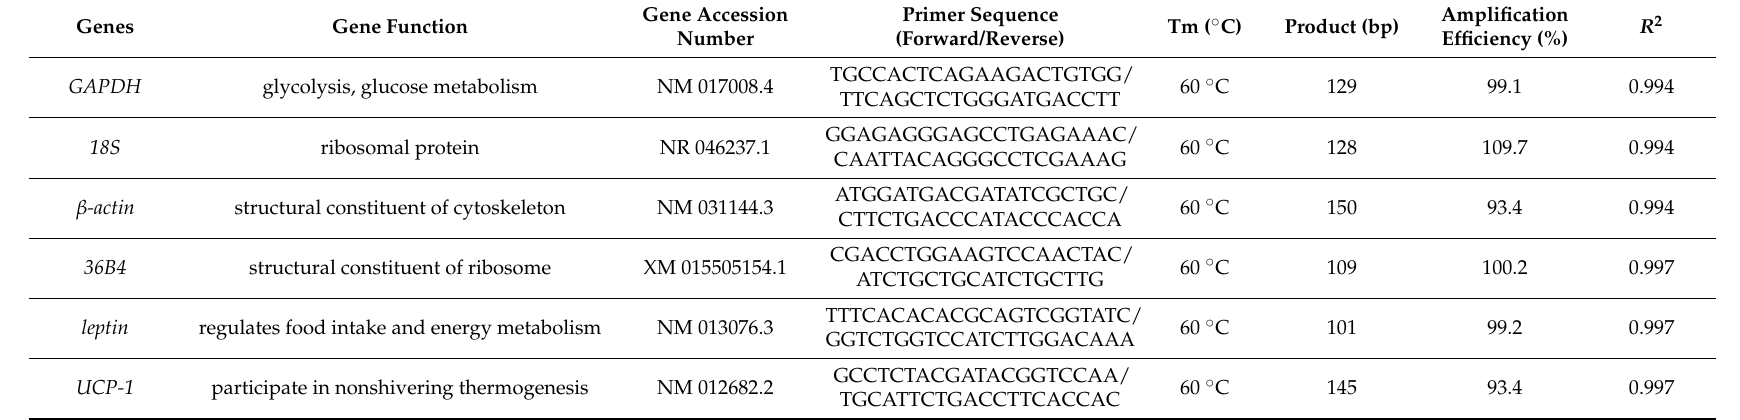
Table 7. Descriptions of reference genes and parameters derived from quantitative real-time polymerase chain reaction